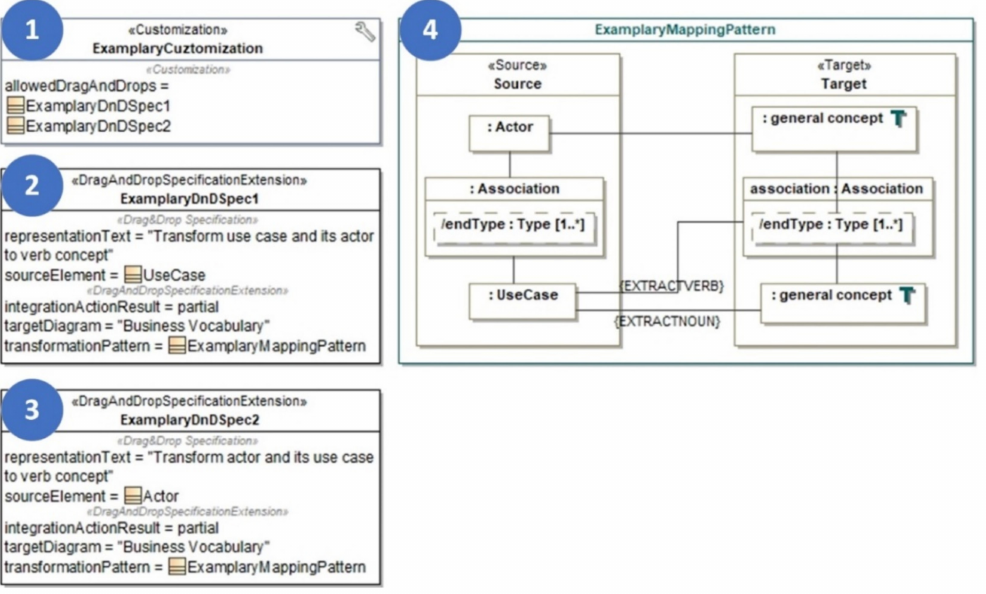
Figure 4. Example of DnD transformations